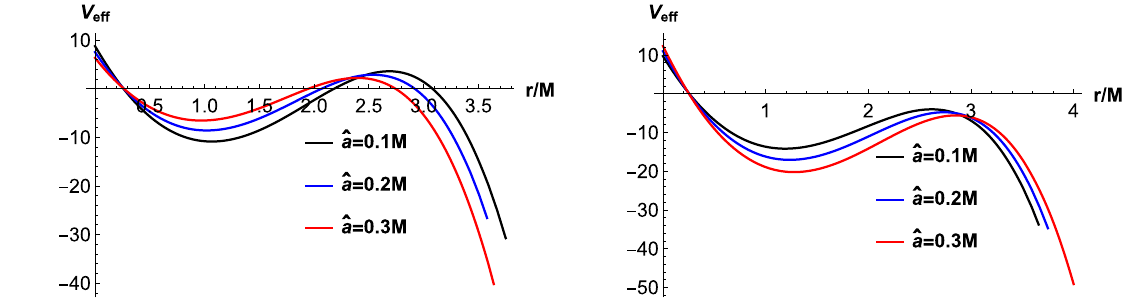
Fig. 11 The left and the right panels describe the effective potential for prograde orbits and the retrograde orbits respectively for various values of ˆ a with b = 0 . 01 M 2 and (cid:2) = 0 . 1